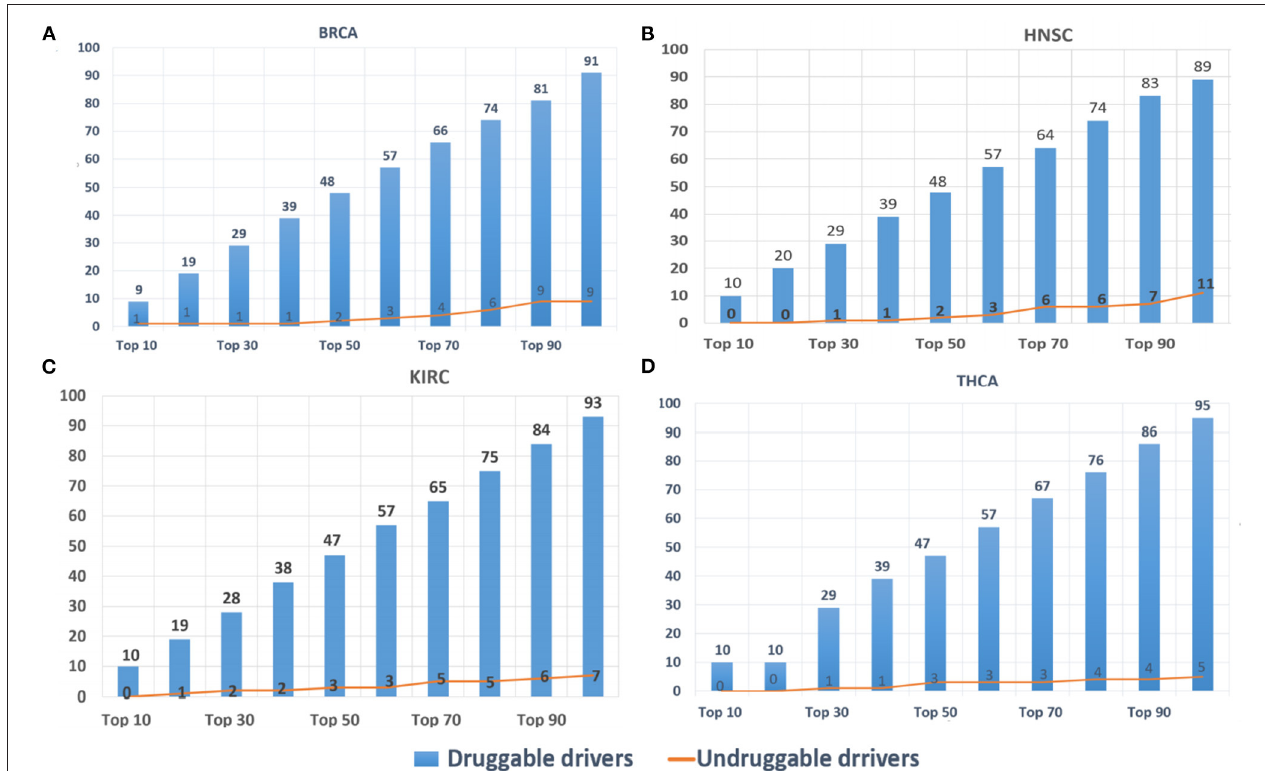
FIGURE 5 | Distribution of top 100 candidate-driver genes from the four cancer gene databases in druggable genes databases. (A) BRCA, (B) HNSC, (C) KIRC, and (D)